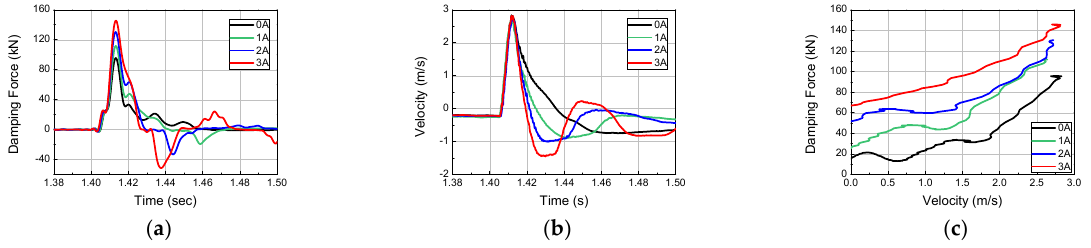
Figure 7. MR damper experimental results at an impact velocity of 5.37 m / s (Test 2): ( a ) Damping force; ( b ) Piston Velocity; ( c ) F-V diagram of MR damper.